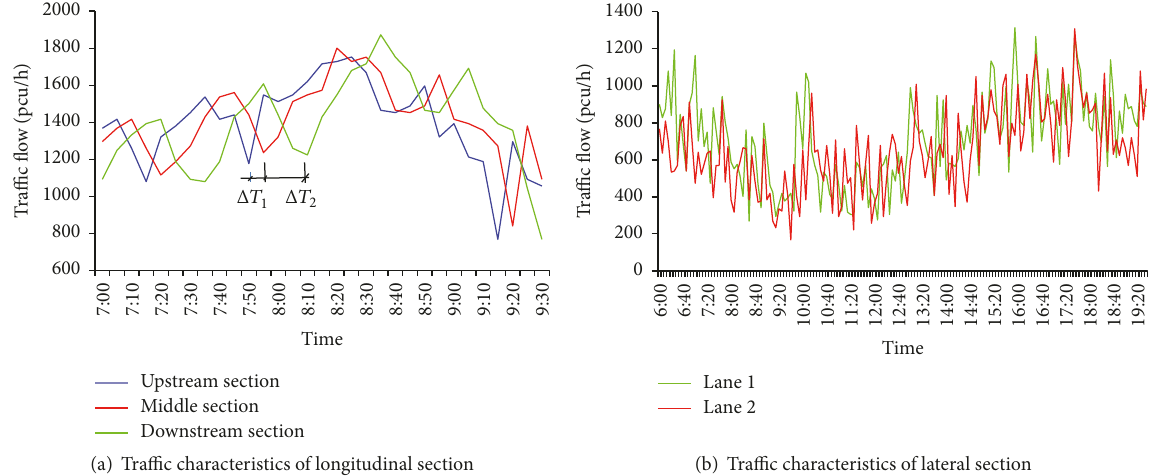
Figure 3: Temporal-spatial characteristics of traffic